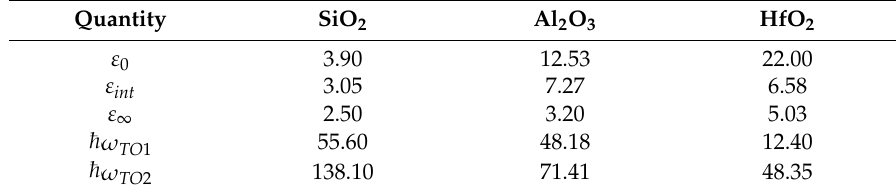
+ 𝜀 (cid:2903)(cid:2919)(cid:2899) (cid:3118) ， (cid:2868)